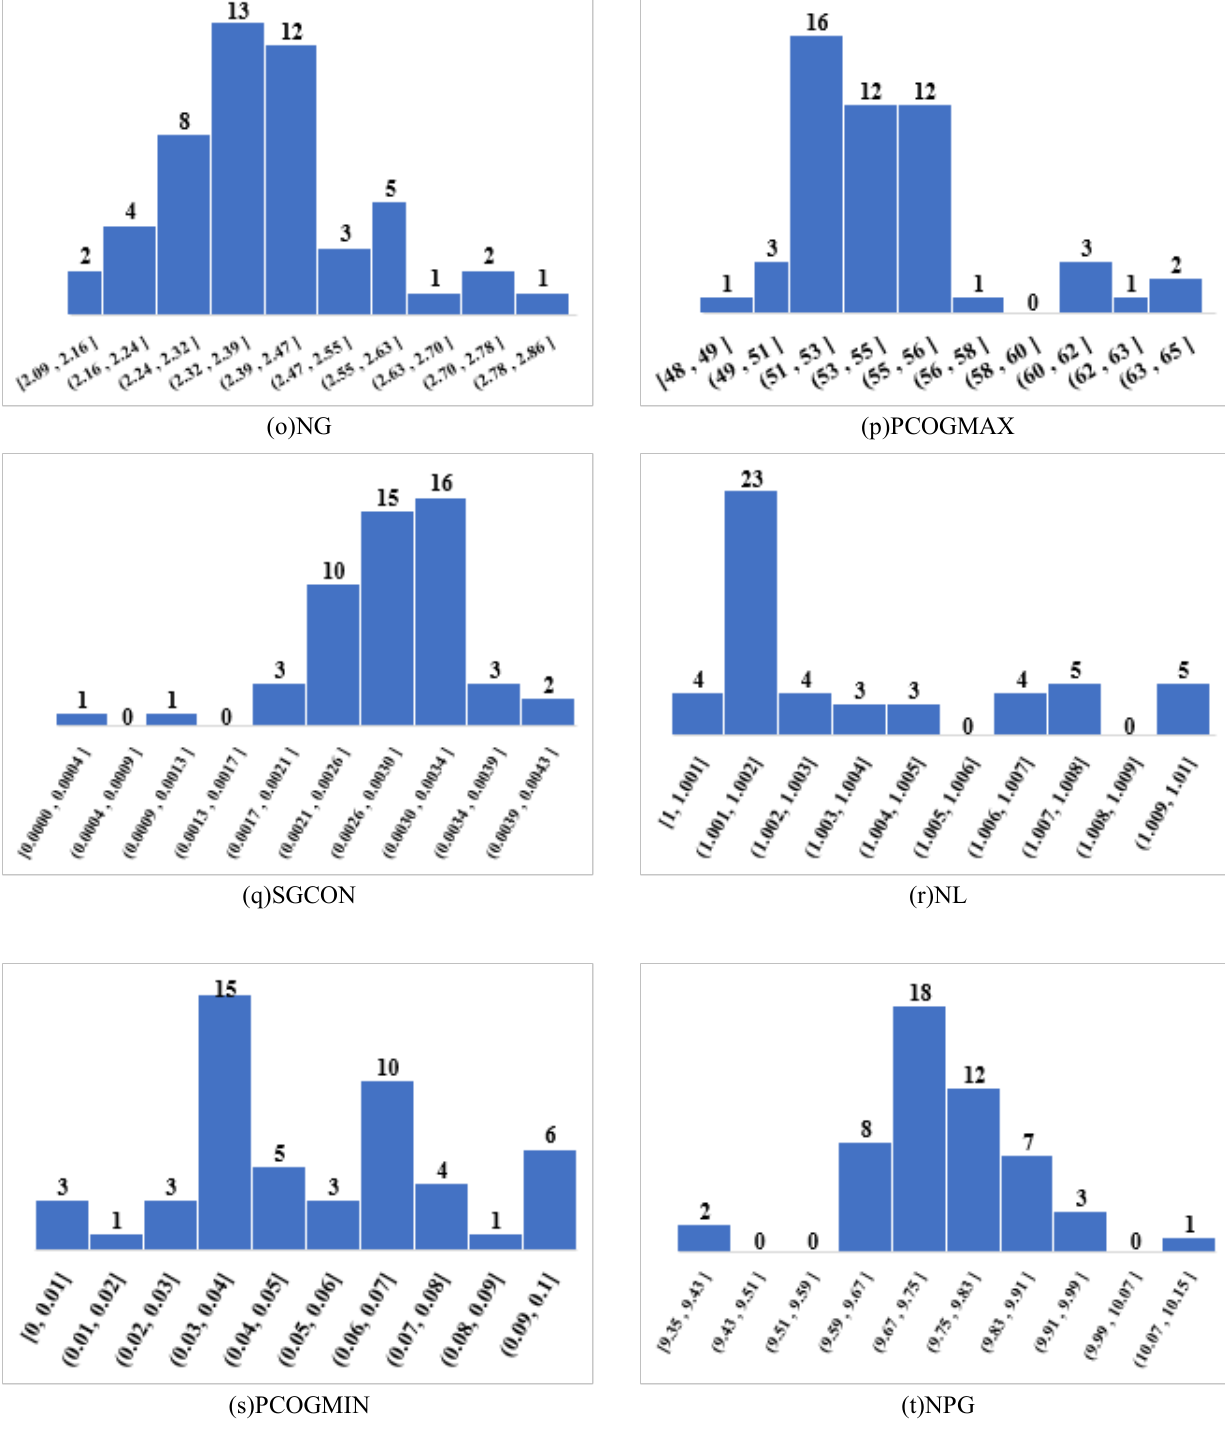
Figure 8—Distribution of 51 groups of model parameters with an error of less than